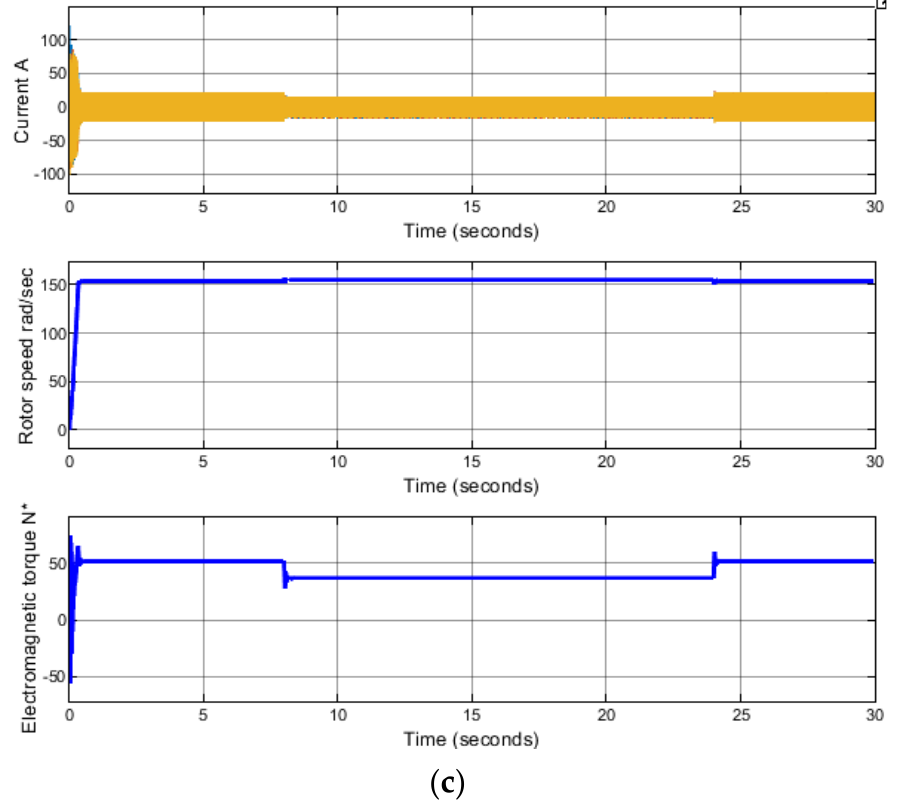
Figure 12. Results of the power supply system simulation model for induction motors. ( a )— M1: Current, rotor speed and moment measurements for Motor1 ; ( b )— M2: Current, rotor speed and moment measurements for Motor 2 ; ( c )— M3: Current, rotor speed and moment measurements for Motor 3 .